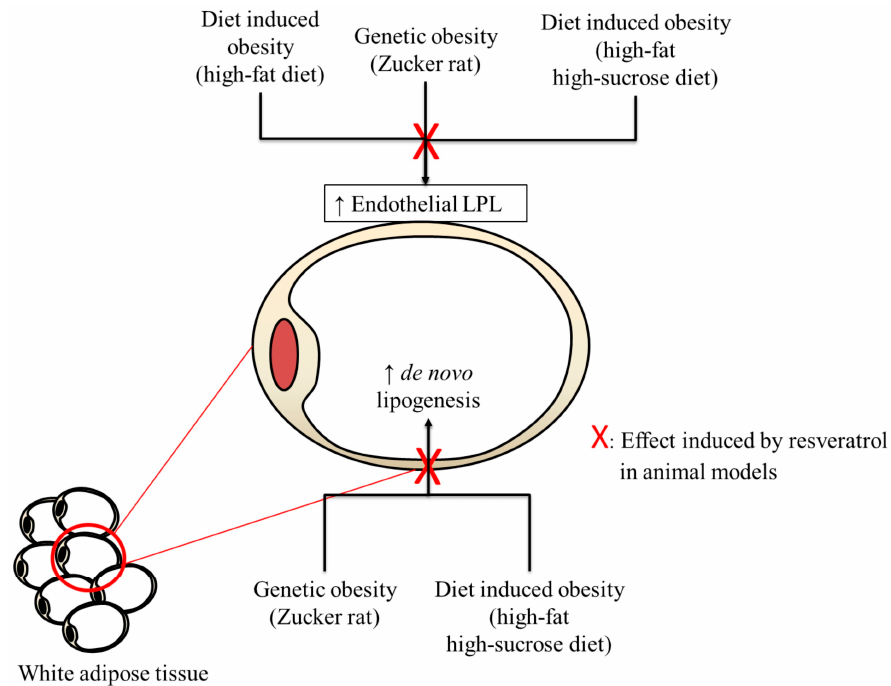
Figure 2. Alterations induced by dietary and genetic obesity in white adipose tissue triacylglycerol metabolism and resveratrol actions.